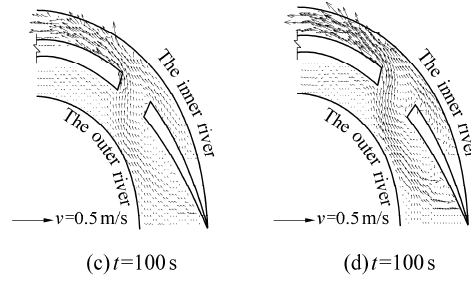
Fig. 7. Typical flow field near the breach. Fig. 7 Typical flow field near the breach.